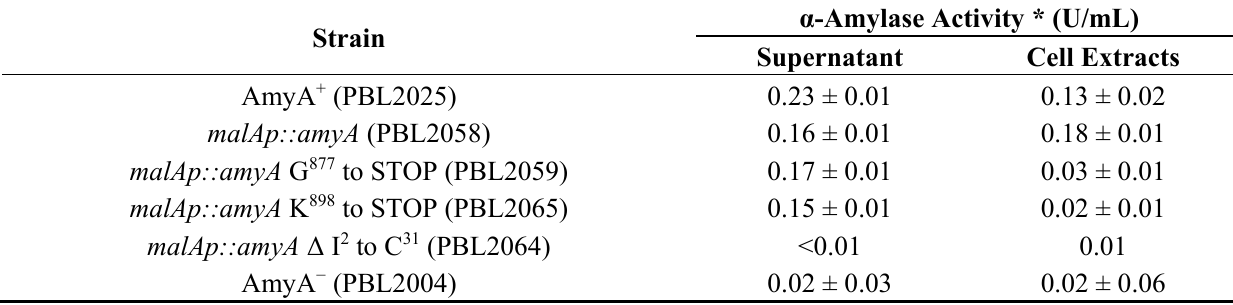
Figure 3. Panel A , The amyA locus, leader sequence deletion. PBL2064 (AmyA leader peptide deletion), deleted amino acids are bracketed, remaining amino acids are shown in bold. Panel B , Efficiency of starch utilization during growth in liquid culture. Strains were; leader peptide mutant (PBL2064, closed squares), wild type (PBL2025; open circles), malAp :: amyA promoter fusion (PBL2058, closed circles) and amyA :: lacS disruption (PBL2004, open squares). Panels C and D , Amy A production during growth on a solid medium. (a) no treatment. (b) Iodine treatment. Numbered spots were: 1 ( malA p- amyA , PBL2058), 2 (Gly877Stop mutant (PBL2059), 3 (Lys898Stop mutant, PBL2065), 4 ( N -terminal deletion mutant, PBL2064), 5 ( amyA :: lacS disruption mutant, PBL2004). All spots contained 10 7 cells and plates were incubated at 80 °C for 6 days. Table 2. α-Amylase activity in selected